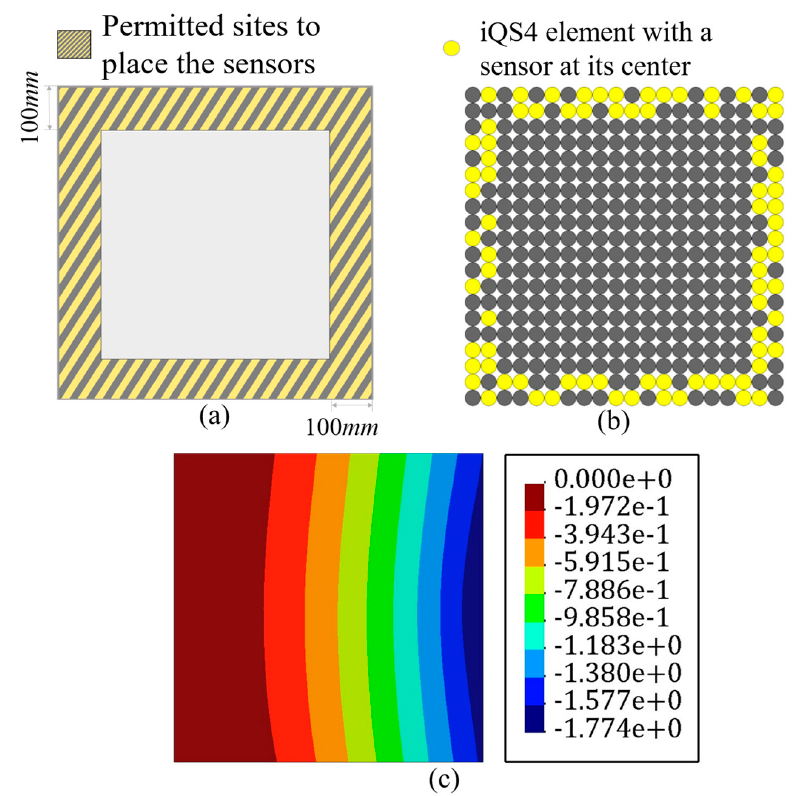
Figure 8. The iFEM-GA results of the plate depicted in Figure 4 with a limited search space. ( a ) The permitted sites to place sensors, ( b ) optimum sensor placement, and ( c ) displacement contours.